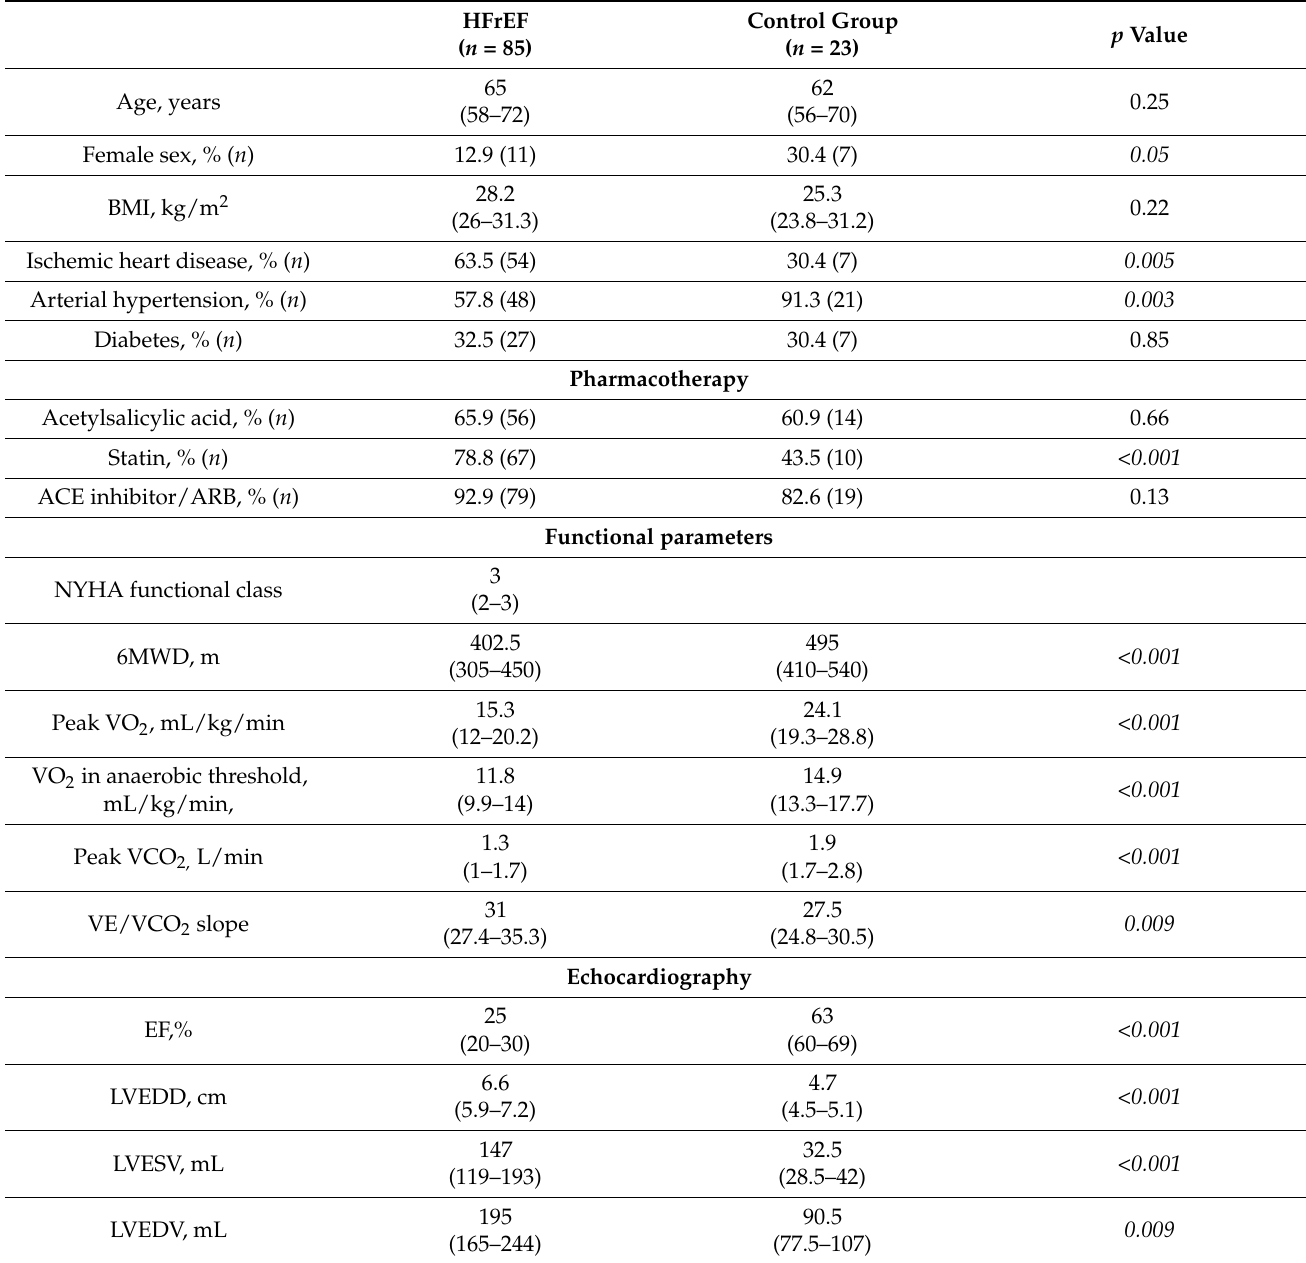
Table 1. Demographic, functional, echocardiographic, and laboratory characteristics of the heart failure patients with reduced ejection fraction (HFrEF) and control